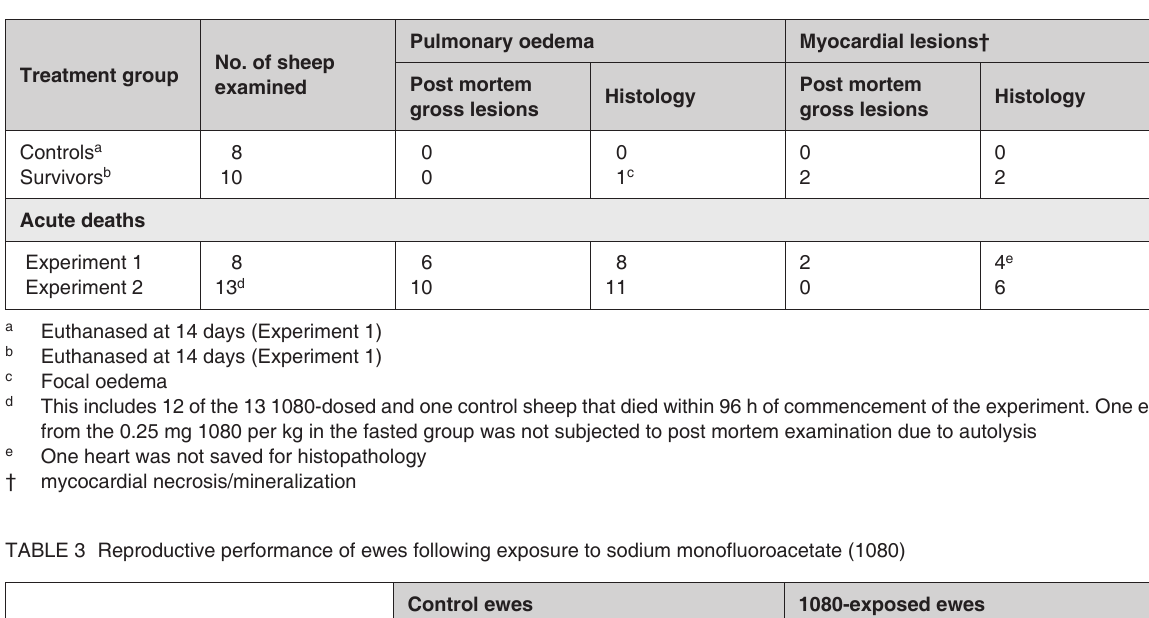
TABLE 2 Pulmonary oedema or myocardial lesions detected at post mortem or on histopathological examination, following exposure to sodium monofluoroacetate (1080)